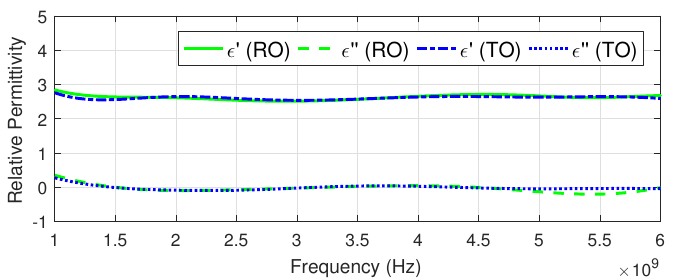
Figure 14. The permittivity of PMMA extracted using Reflection Only (RO) and Transmission Only (TO) methods, using experimental data with r = 48 cm.